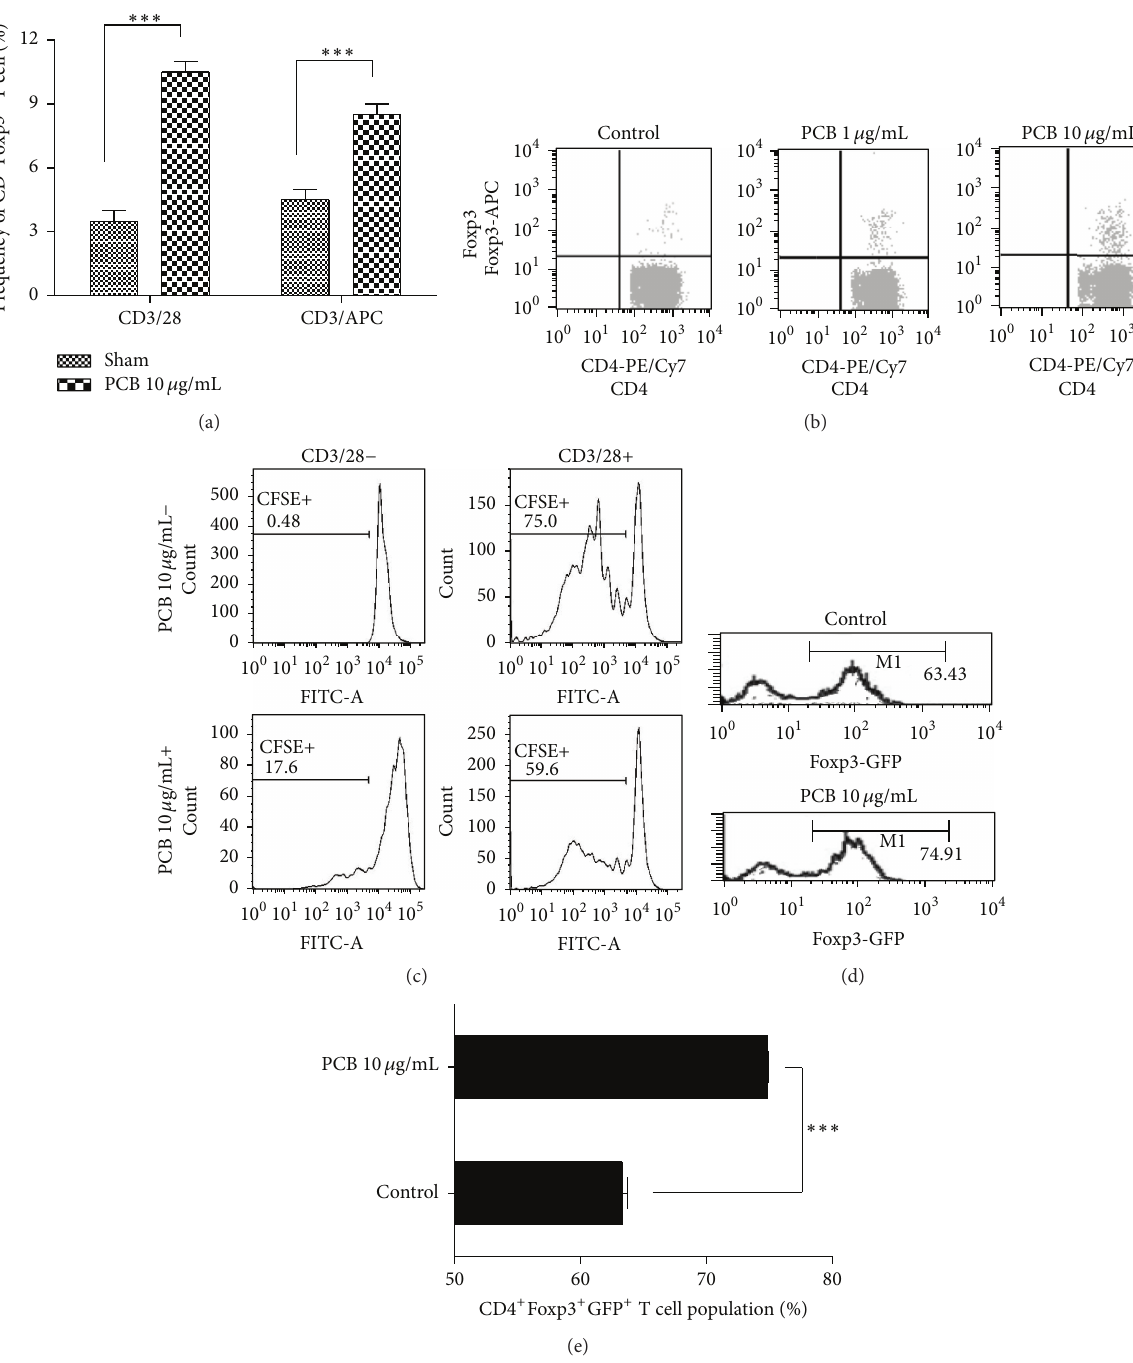
Figure 6: PCB extract affects the generation and functional Foxp3 + T regulatory cells and stabilizes the Foxp3 expression of regulatory T cells. (a) and (b) CD4 + CD62L + na¨ıve T cell from splenocytes and mLN cells from BALB/c mice were cultured with 10 𝜇 g/mL plate-bound anti- CD3 monoclonal antibody and 2 𝜇 g/mL soluble anti-CD28 mAb, or with 10 𝜇 g/mL plate-bound anti-CD3 mAb and APCs, in the presence of 0–10 𝜇 g/mL PCB. After three days, the expression of Foxp3 in gated CD4 + cells was analyzed using flow cytometry. A plot from one representative experiment shows the frequency of Foxp3 + CD4 + T cells. (c) CD4 + T cells from each group were cocultured with CD4 + CD62L + na¨ıve T cells labeled with CFSE (5 𝜇 M), 10 𝜇 g/mL plate-bound anti-CD3 mAb, and 2 𝜇 g/mL soluble anti-CD28 mAb. The CFSE + population was then analyzed using FACS. (d) Ag-specific GFP + nTregs were sorted from the OT-II transgenic Foxp3-GFP knock-in mice and transferred to normal recipients. Five days after immunization, the transferred CD45.2 + cells were analyzed for Foxp3 expression using flow cytometry. (e) The numbers in M1 represent the percentage of Foxp3 + cells. The plot presents the mean percentage of CD45.2 + Foxp3 + T cells of three independent experiments. Data are presented as the mean ± SD of triplicate determinations and were analyzed using unpaired 𝑡 -test. ∗∗∗ 𝑃 < 0.001 versus